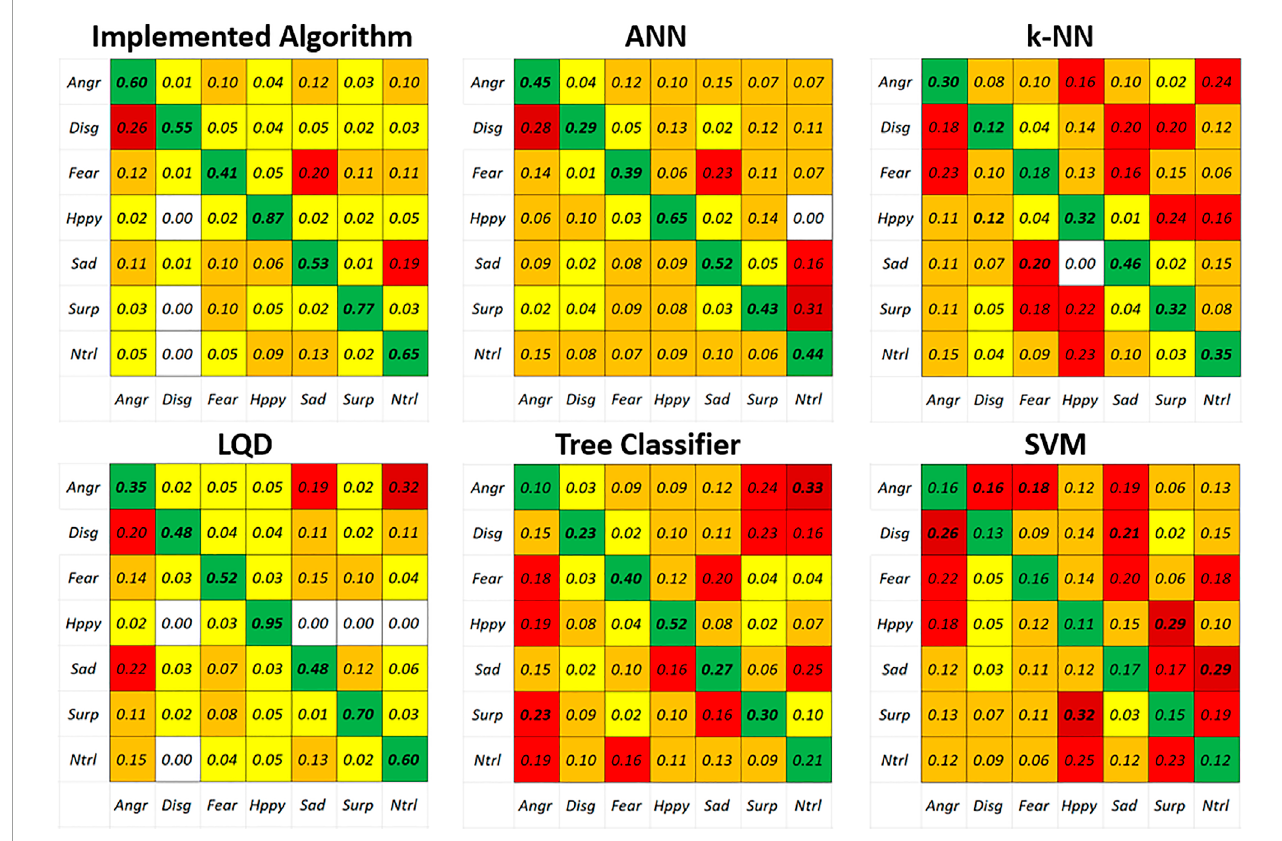
FIGURE 7 Comparison of different classification algorithms for the FER task running over the FER-2013